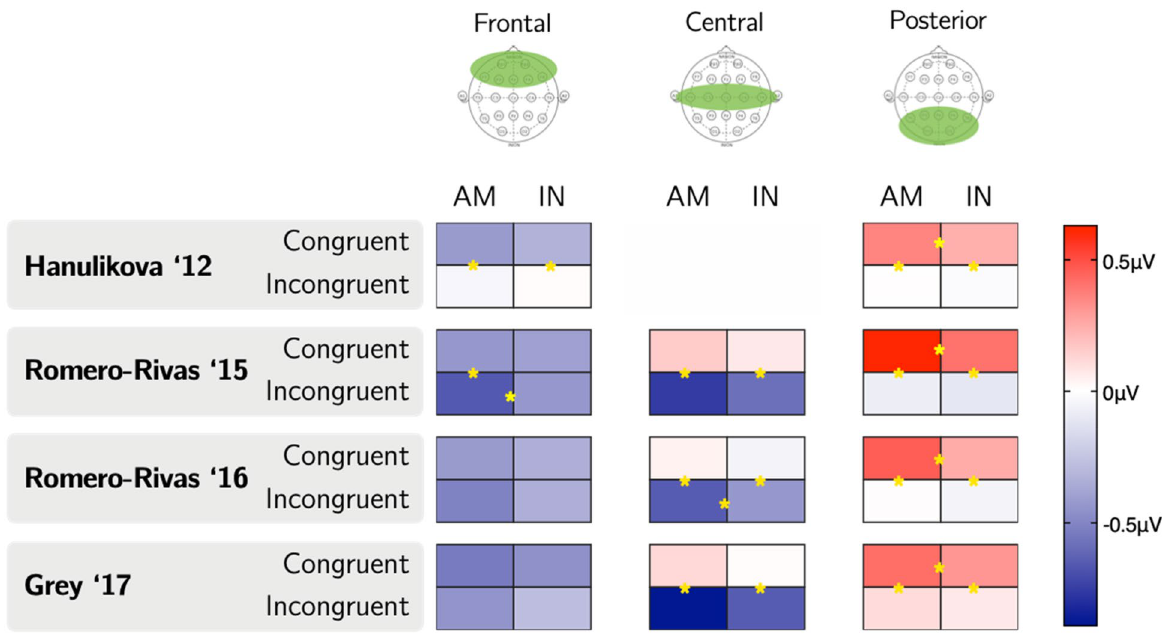
Figure 3. A graphical representation of average amplitudes in microvolts for each condition in the N400 time range for each parameter set, with a star on a line indicating a difference between conditions sharing that line significant at p <